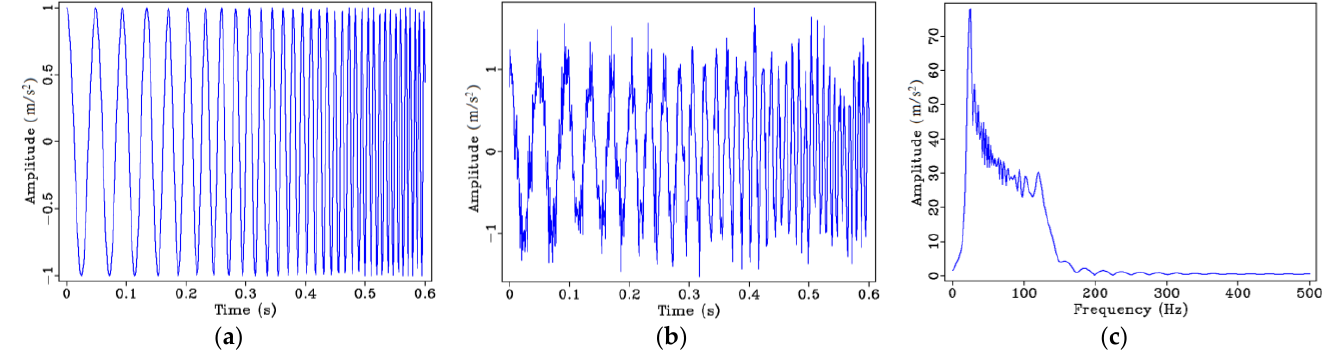
Figure 3. Nonlinear frequency-varying signal model: ( a ) Time domain signal; ( b ) time domain signal with 10% random noise; ( c ) frequency spectrum of ( a ).